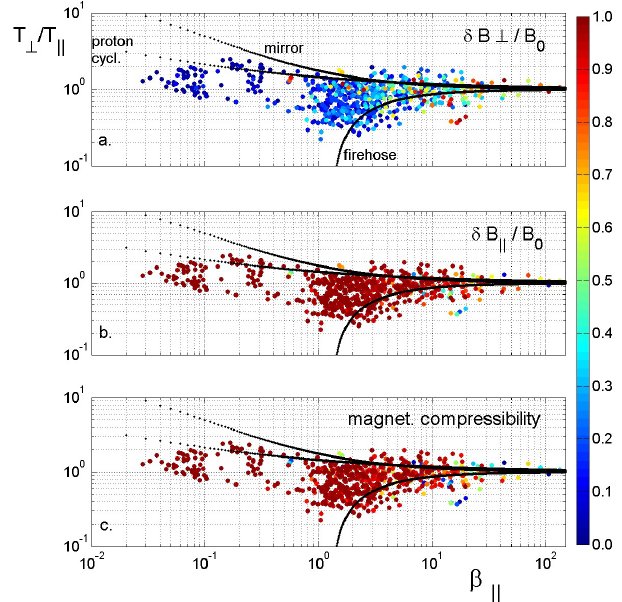
Fig. 6. Proton temperature anisotropy versus parallel plasma β k . The color code corresponds to the strength of (a) normalized per- pendicular magnetic fluctuations; (b) normalized parallel magnetic fluctuations; (c) magnetic compressibility. The dotted lines corre- spond to proton cyclotron, mirror and oblique firehose instability